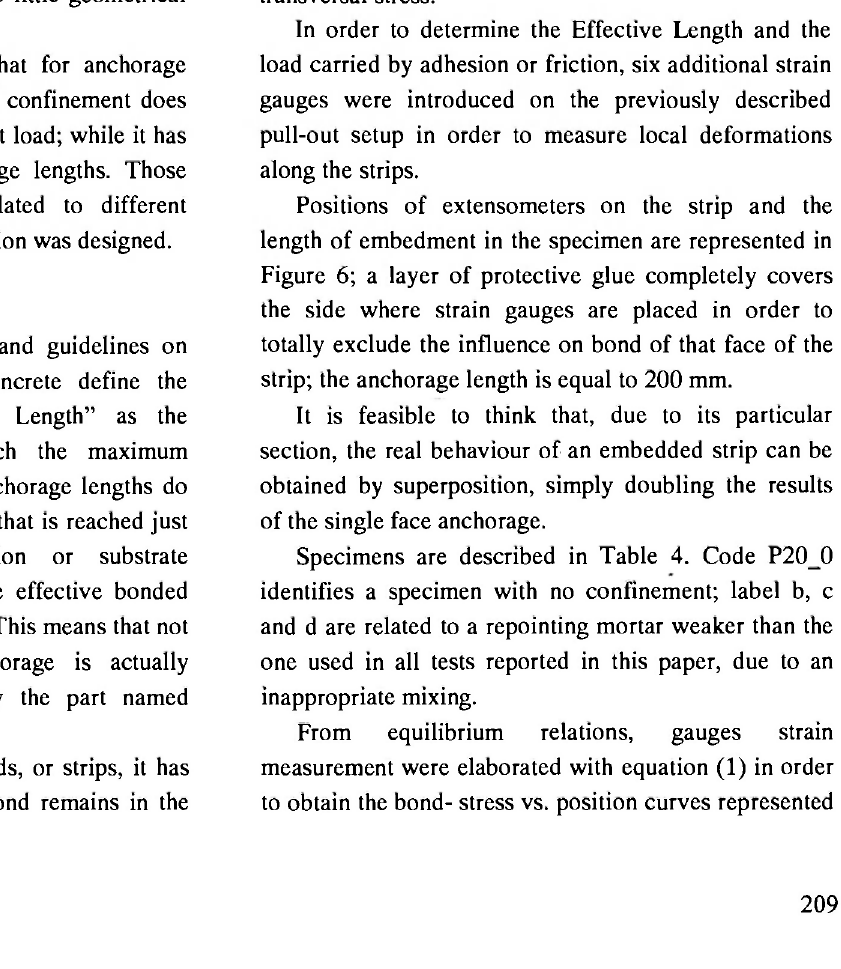
Fig. 5: Pull-out test results. Extracting load and average bond stress along the anchoring length at different confining stress